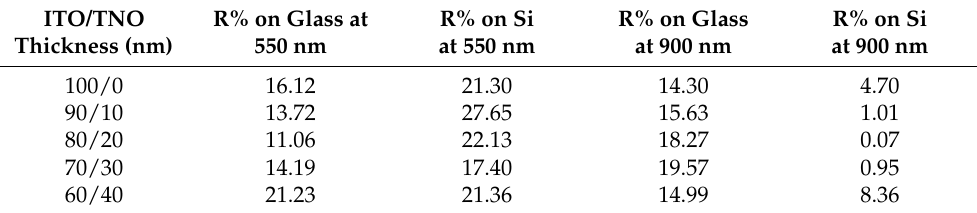
Figure 8. ( a ). Reflectance spectra of double-layer ITO/TNO with different thickness combinations deposited on the silicon substrate as a function of wavelengths. ( b ) Schematic diagram of double-layer ITO/TNO on the silicon substrate explains the graded refractive index lamination effect. Table 4. Respective R% at the central wavelength of 550 nm and at crystalline silicon photo response wavelength of 900 nm for double-layer ITO/TNO with different thickness combinations deposited on glass and silicon substrates.